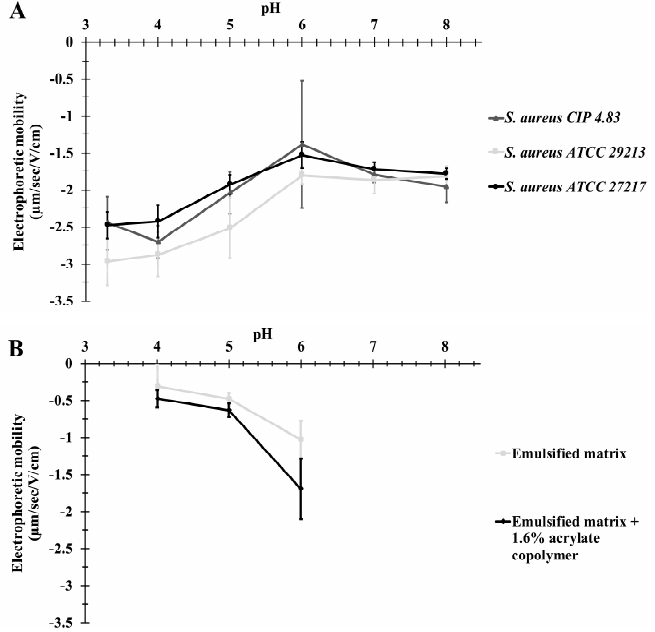
Figure 1. Electrophoretic mobility of the three S. aureus strains ( A ) and the lipid droplets of a model matrix ( B ) at a pH from 3 to 8. Data are expressed as the mean ± standard deviation of two biologic replicates.